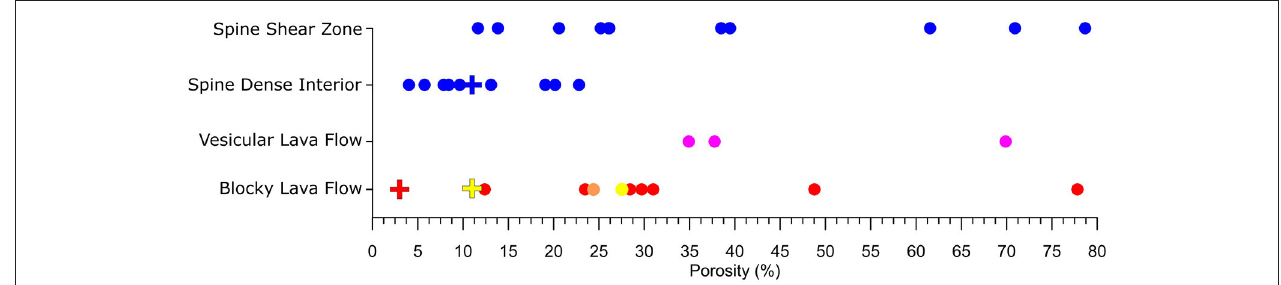
FIGURE 5 | Total porosity of extrusive products at Santiaguito. Circles are data from this study, and crosses are values from Avard and Whittington (2012). Blocky lava flows are separated into: summit blocky flows (yellow), blocky lava flows that reach the base of the cone but do not extend further than 2.5km length (orange), and blocky lava flows > 2.5km (red). Less than 1% of the porosity was isolated in all the samples used in this study, so only total porosity is shown, equivalent to the connected porosity.